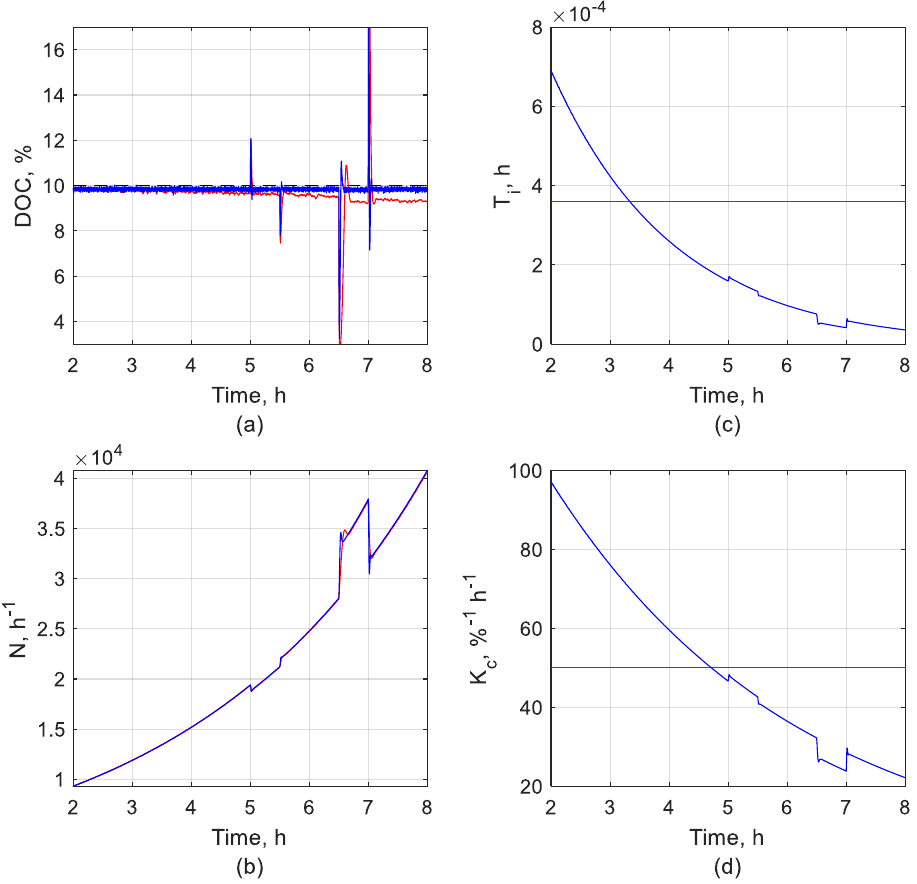
Figure 6. Trajectories of DOC ( a ), controller tuning parameter T i ( b ), stirring speed N ( c ), and controller tuning parameter K c ( d ). Disturbance rejection when using: PI controller with fixed parameters (red), adaptive PI controller with Gain Scheduling (blue); DOC set-point (black).